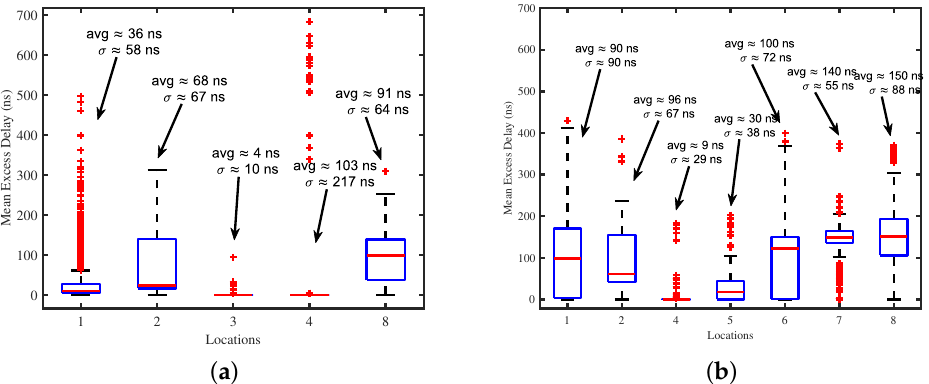
Figure 8. Box plot for Mean excess delay for Op1 and Op2 at all measurement locations, showing median value (red line), standard deviation (blue box), and outliers (red Plus signs). ( a ) Op1 ( b )